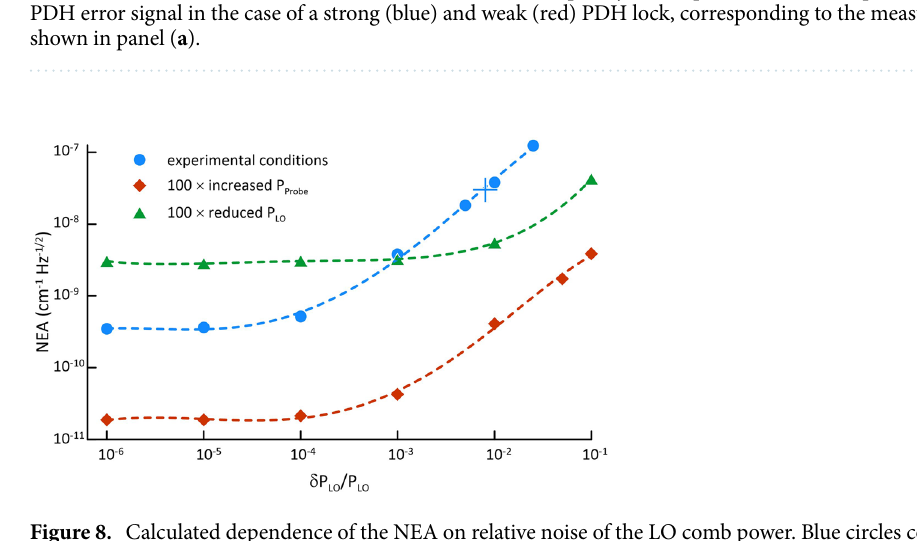
Figure 8. Calculated dependence of the NEA on relative noise of the LO comb power. Blue circles correspond to our experimental conditions of the probe and LO comb powers of 30 µW each, red squares were calculated for a 100-fold increase in the probe power, and green triangles were based on a 100-fold reduction in the LO power. Dashed lines are included to guide the eye. The asymptotic values of NEA at the lowest relative LO noise level, δP LO /P LO , correspond to the shot-noise limits. The indicated blue symbol + corresponds to our experimental NEA from which our experimental δP LO /P LO was